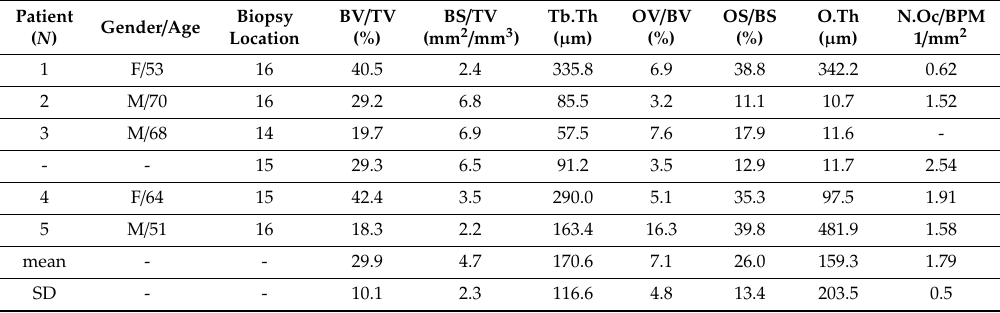
Table 3. Histomorphometric evaluation of the six biopsies from five patients in whom a maxillary sinus floor elevation (MSFE) procedure was performed with a mixture of autogenous bone from the maxillary tuberosity and Straumann ® bone ceramic (60:40) after 6 months healing time. Patient ( N )